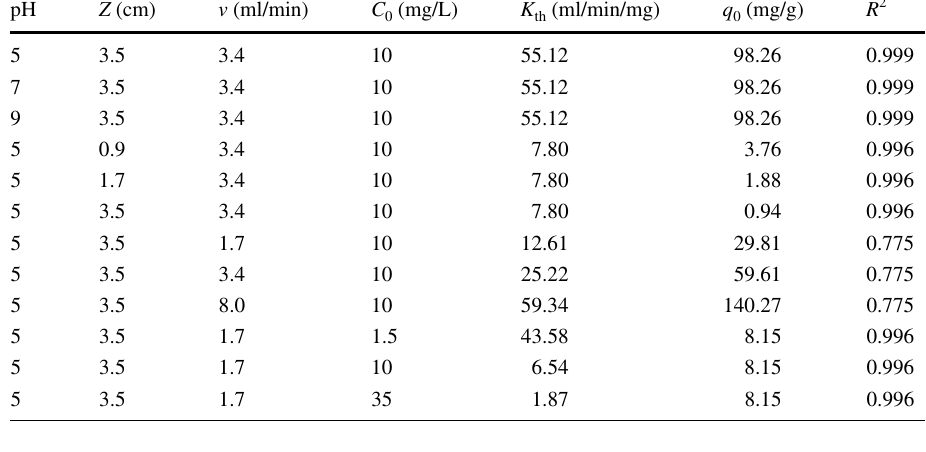
Fig. 8 BDST model at break- through curve in fixed-bed column for F adsorption by banana peel